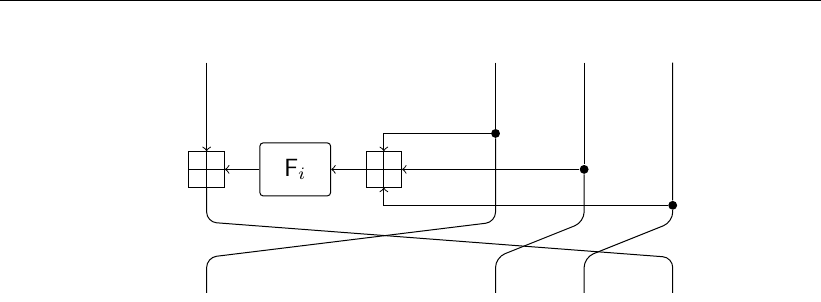
Figure 1: One round of a contracting Feistel cipher with t = 4 branches. The function F i is a permutation and possibly